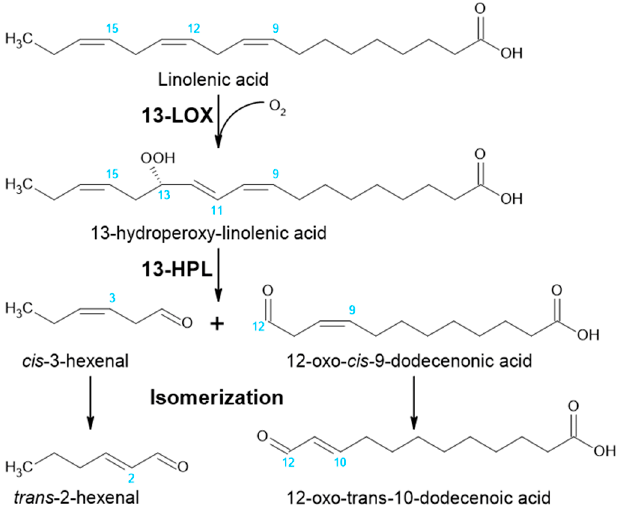
Figure 1. Lipoxygenase pathway with C ‐ 13 specific LOX and